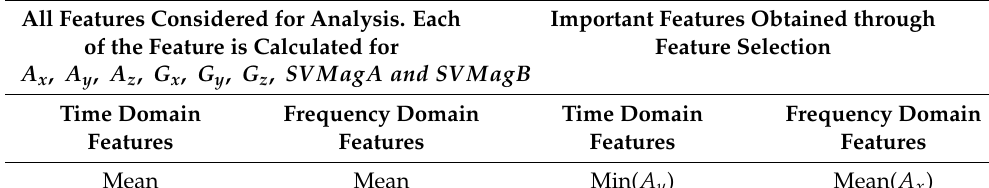
Figure 5. SVMag of Accelerometer readings for activity lyingleft corresponding to the raw data plotted in Figure 4. Table 2. List of time and frequency domain